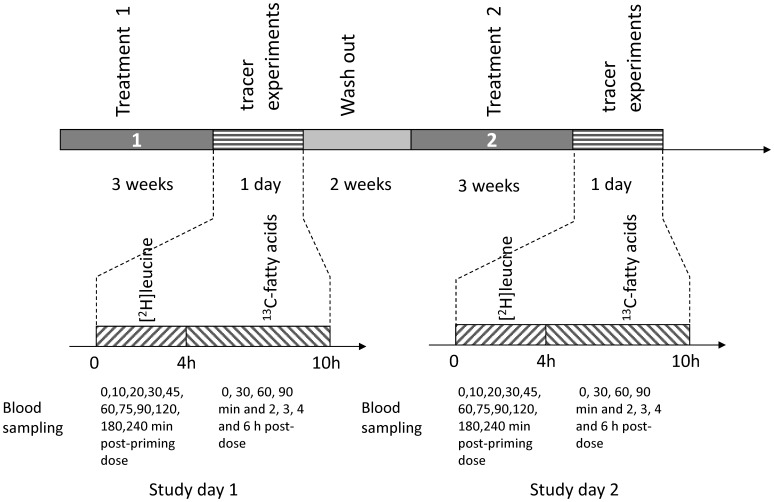
Schematic overview of the test day.